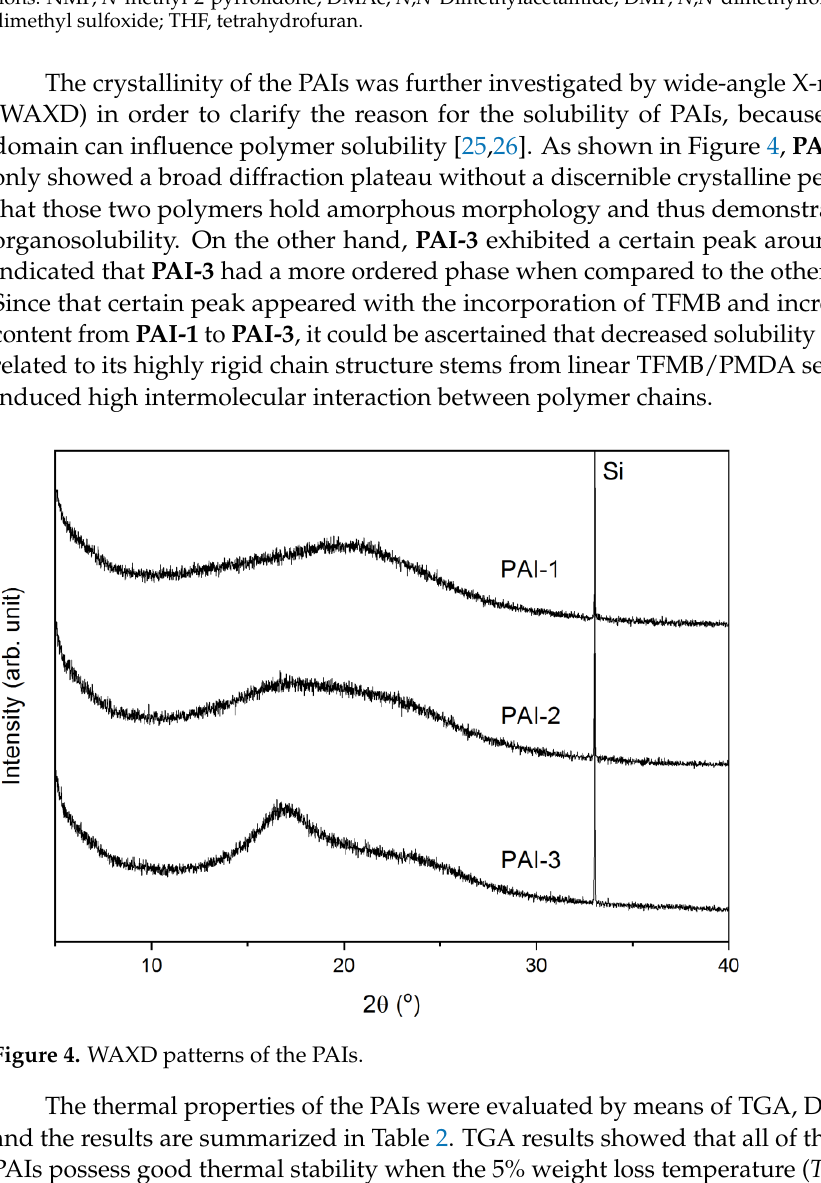
ble. Abbreviations: NMP, N -methyl-2-pyrrolidone; DMAc, N , N -Dimethylacetamide; DMF, N , N -